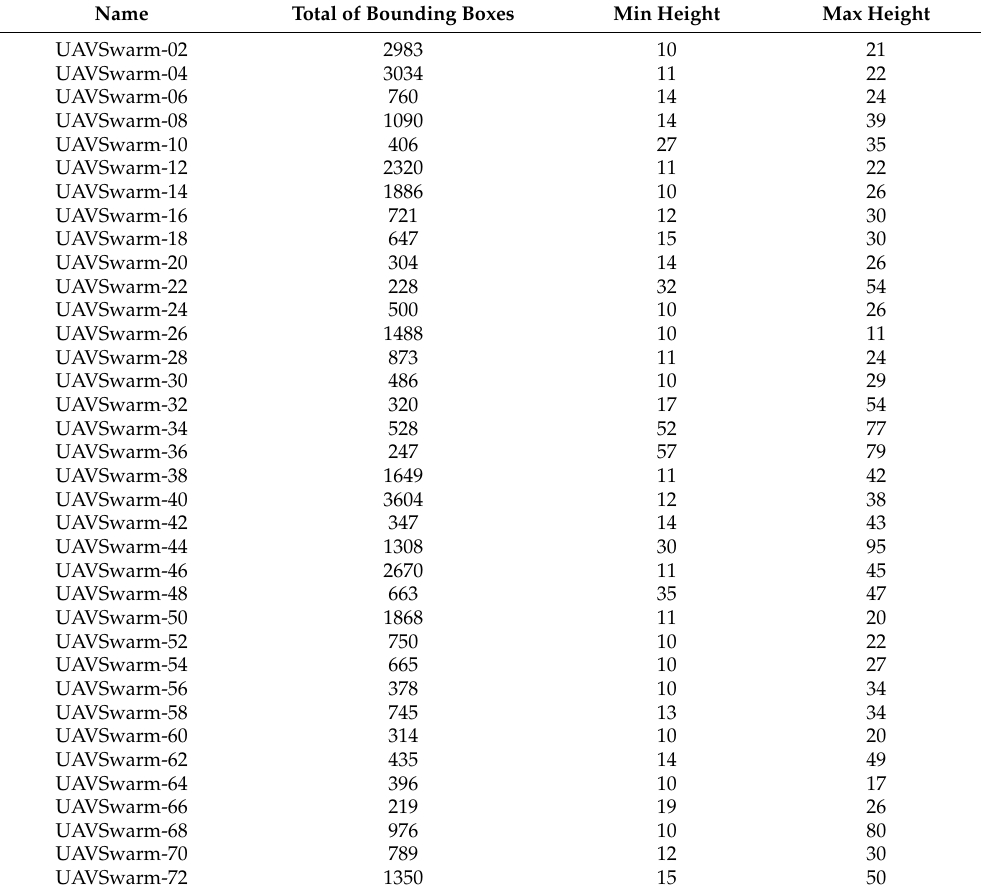
Table 4. The bounding box information of the testing sequence in the UAVSwarm